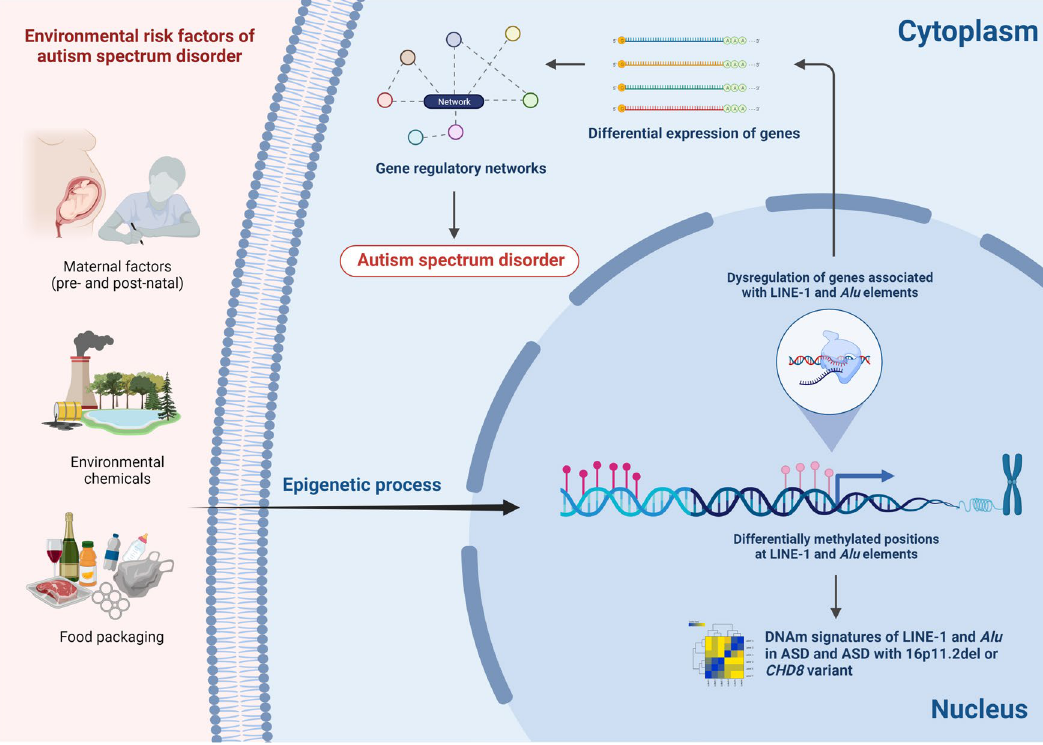
Figure 6. Schematic diagram illustrating a possible mechanism of LINE-1 and Alu elements in ASD (created with https:// biore nder.